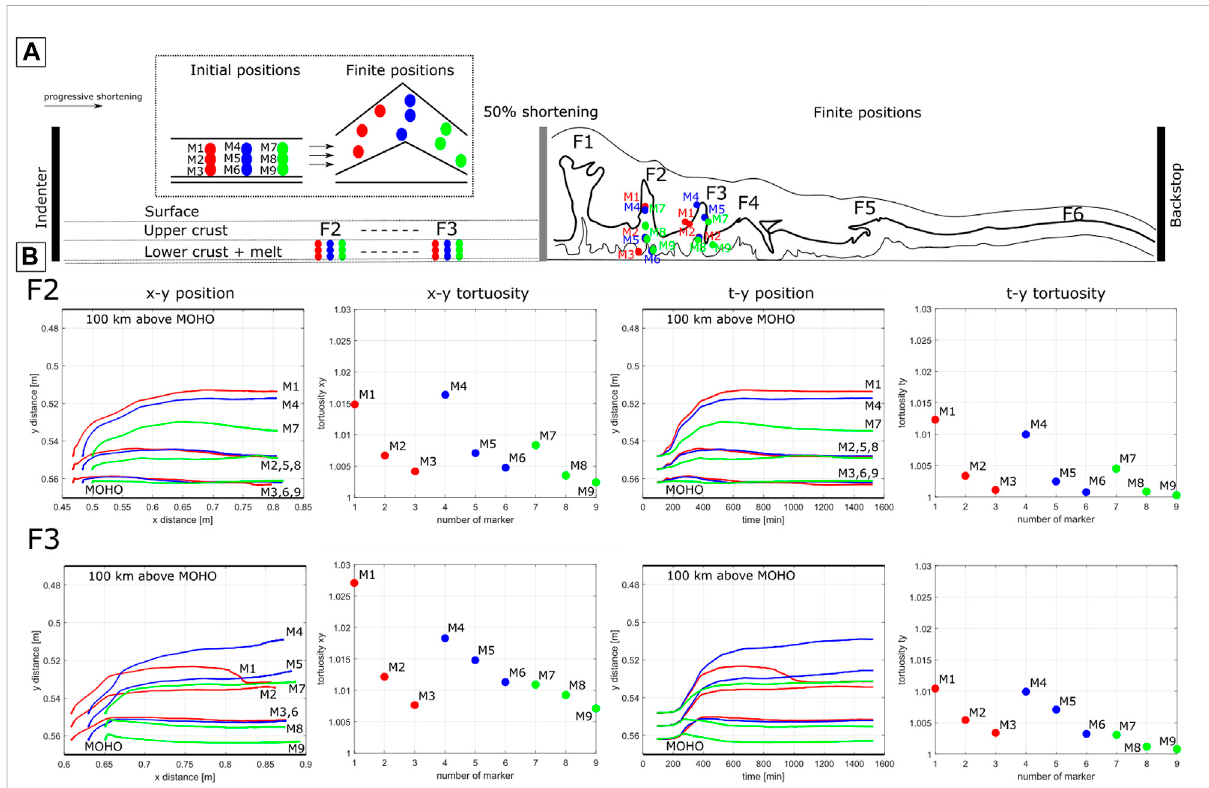
FIGURE 6 Numerical analysis of fold kinematics in Experiment #8 (folds F2 and F3). (A) The prede fi ned positions of traced markers are shown in schematics of the model ’ s initial and fi nite state (red-blue-green markers). (B) Diagrams on the left display x-y (space-space) position of selected markersforalltime-stepsandassociatedtortuosityfortheirpaths.Diagramsontherightdisplay t-y (time-space)evolutionandassociatedtortuosity forthesamemarkers.Verticalandhorizontalspacedimensionsareshownin[m]andreferentialoriginofcoordinatescorrespondswithposition out of displayed area (origin corresponds to the PIV coordinates origin). To illustrate the proportionality with respect to natural systems, we marked the MOHO level and the position 100 km above the MOHO into diagrams (erosion and sedimentation is not simulated in our models). For further information about methodology and results follow the main text and Supplementary